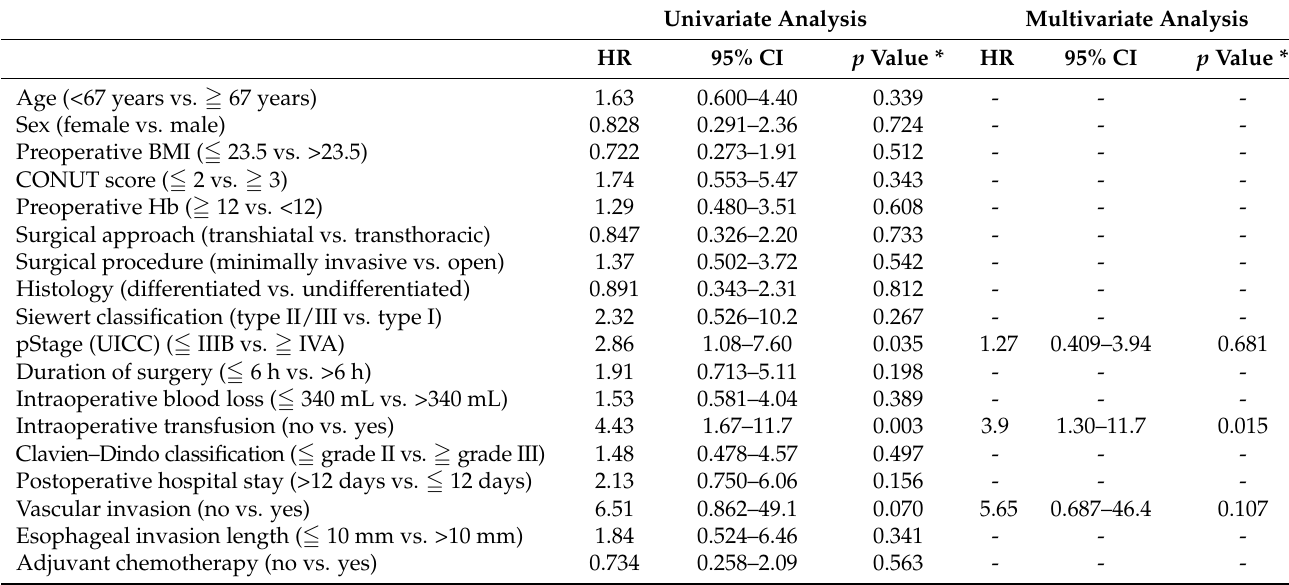
Table 5. Cox proportional hazards model for overall survival. Univariate Analysis